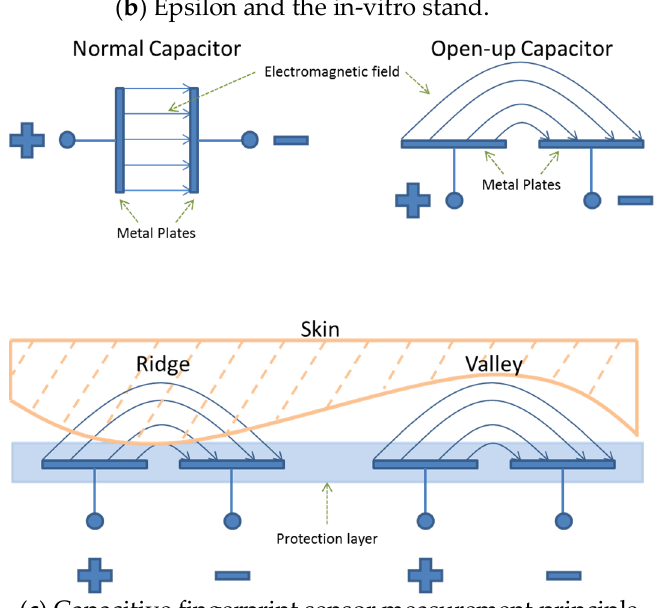
Figure 1. Epsilon Permittivity Imaging System: ( a ) Epsilon and the in-vivo stand; ( b ) Epsilon and the in-vitro stand; ( c ) its measurement principle.